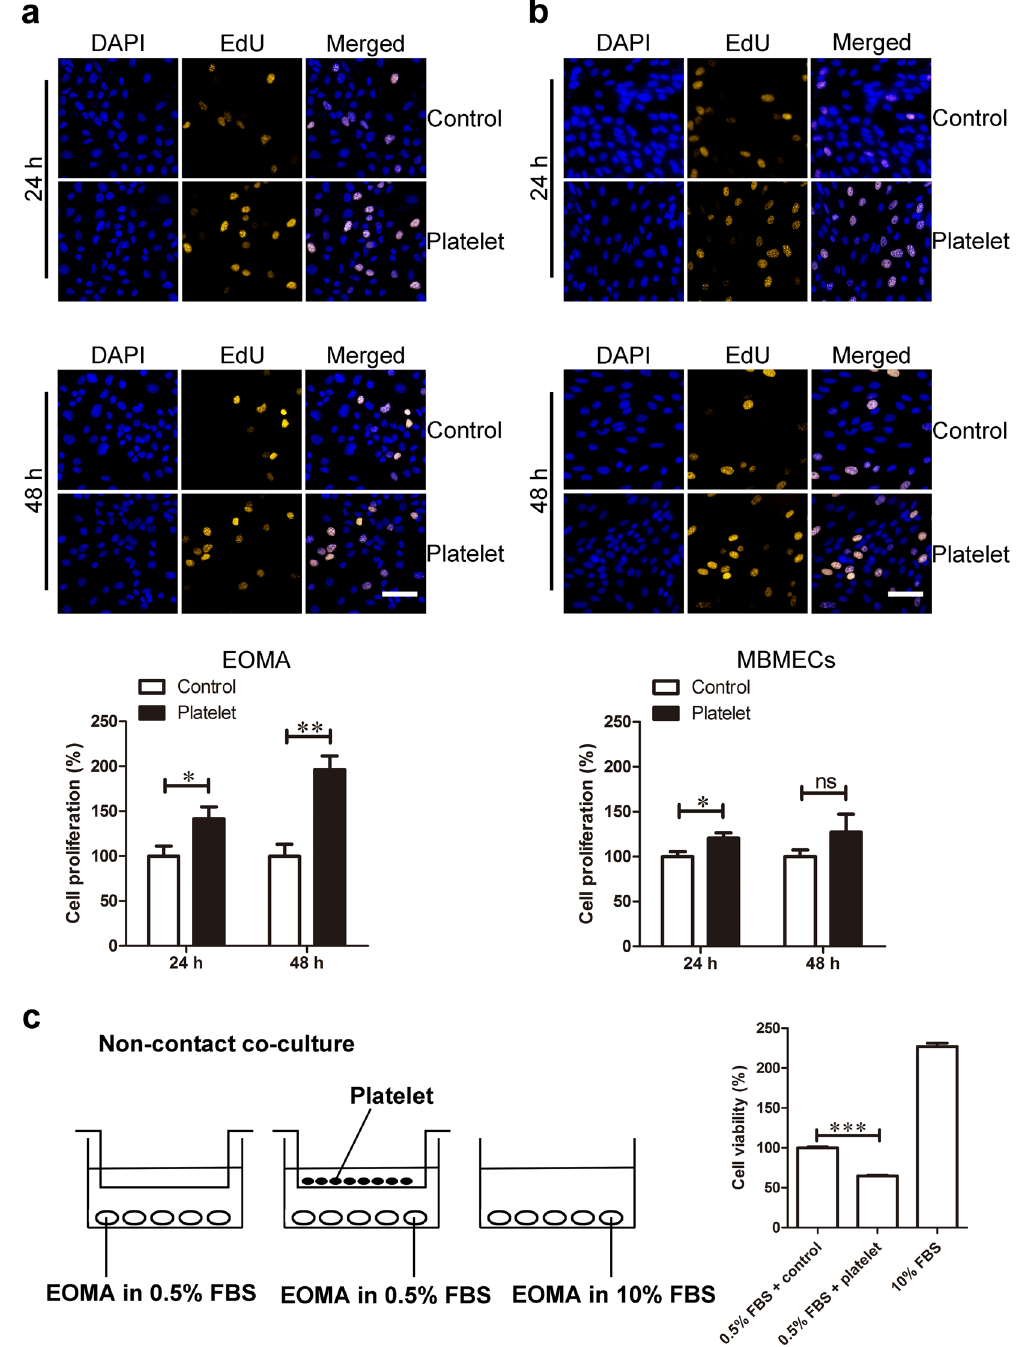
Figure 2. Platelet treatment induced EOMA cell proliferation. ( a ) EOMA cells and ( b ) MBMECs were incubated with platelets for either 24 or 48 hours. EdU (yellow) and DAPI (blue) staining was used to examine the cell proliferation. Scale bar, 60 μ m. n = 5, t-test. ( c ) EOMA cells were incubated with platelets in a non- contact co-culture for 72 hours. The cell viability was examined by CCK8 assay. n = 4, one-way ANOVA. * P < 0.05; ** P < 0.01; *** P < 0.001; ns, not